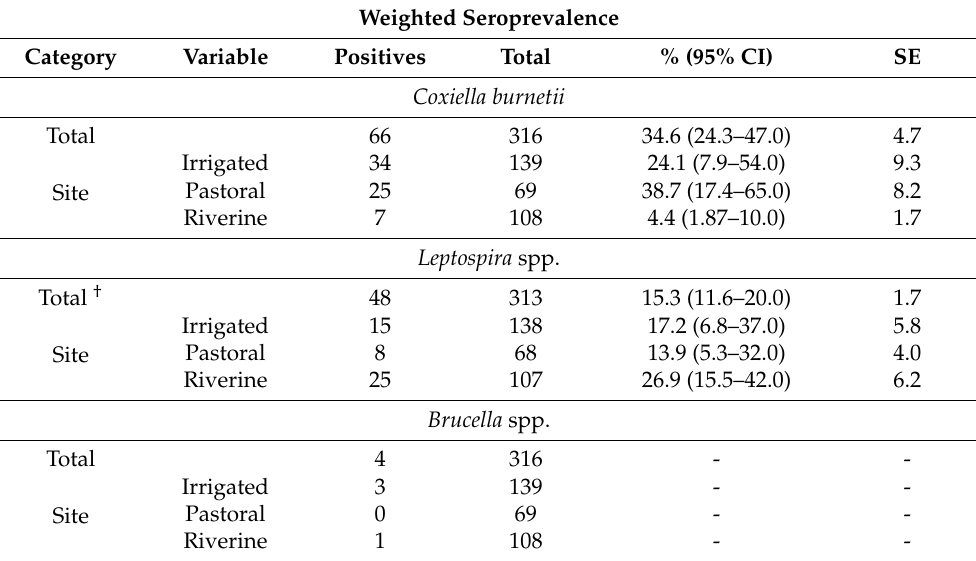
Table 3. The distribution of seroprevalence estimates for the three bacterial zoonoses. Seroprevalence was calculated using the first sampling time point of all animals. When the weighted estimates could not be reliably determined, the cells are left blank and only the unadjusted numbers are